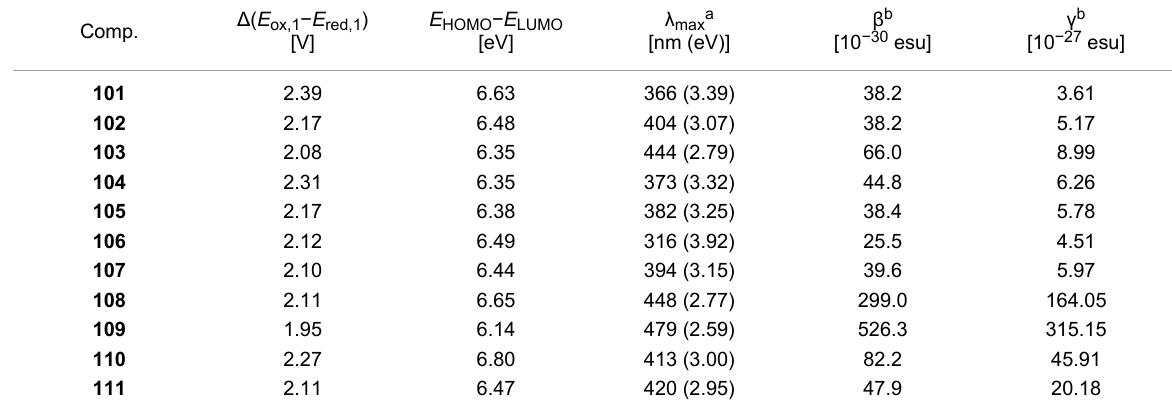
Table 13: Diimidazole chromophores 101 – 111 ; properties [20].